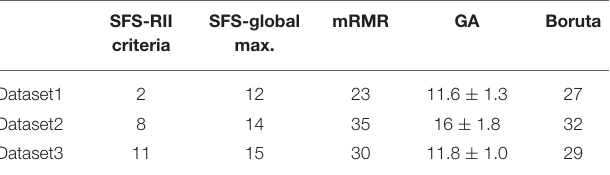
TABLE 2 | The grip with highest classification error for each dataset, using each FS method. SFS-RII SFS-global criteria max.